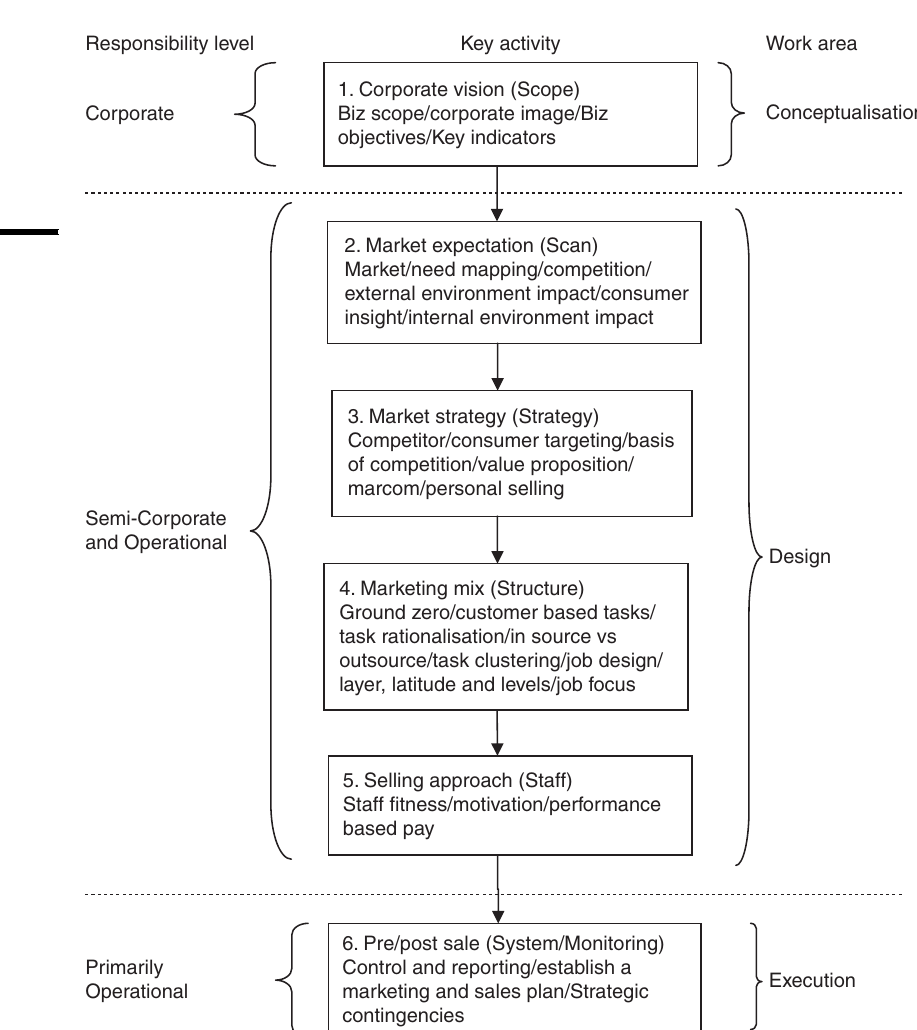
Figure 1. Model of the marketing